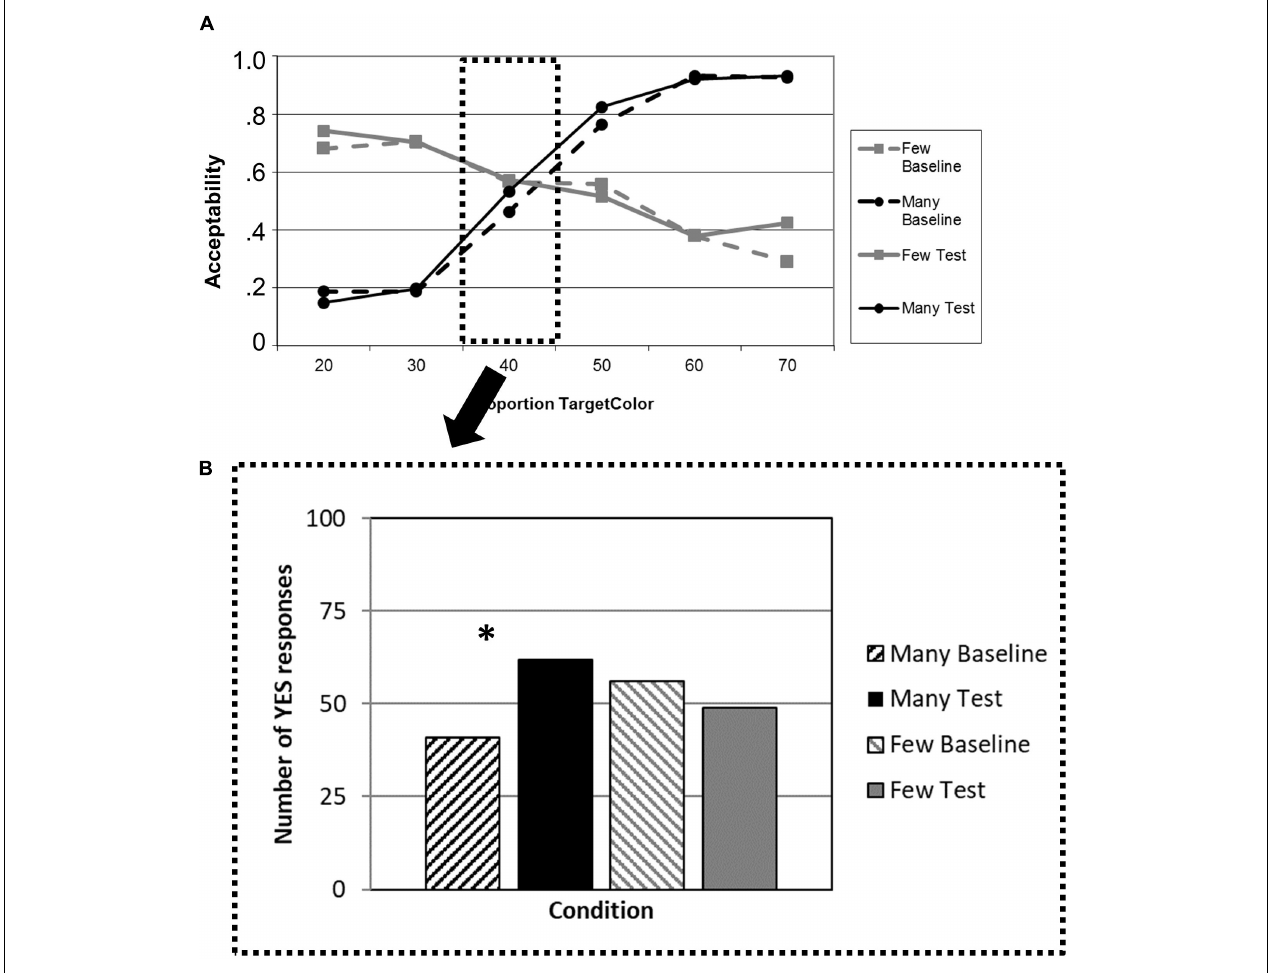
FIGURE 2 | (A) Patients’ average acceptability ratings for a given proportion of circles of the mentioned color, plotted separately for the quantifiers “ many ” (black lines) and “ few ” (gray lines) in the baseline blocks (dashed lines) and the test blocks after adaptation (solid lines). (B) Number of “yes” responses for the critical proportion (40%) of circles of the mentioned color, plotted separately for “ many ” (black bars) and “ few ” (gray bars) in the baseline blocks (dashed bars) and the test blocks after adaptation (solid bars). ∗ p <